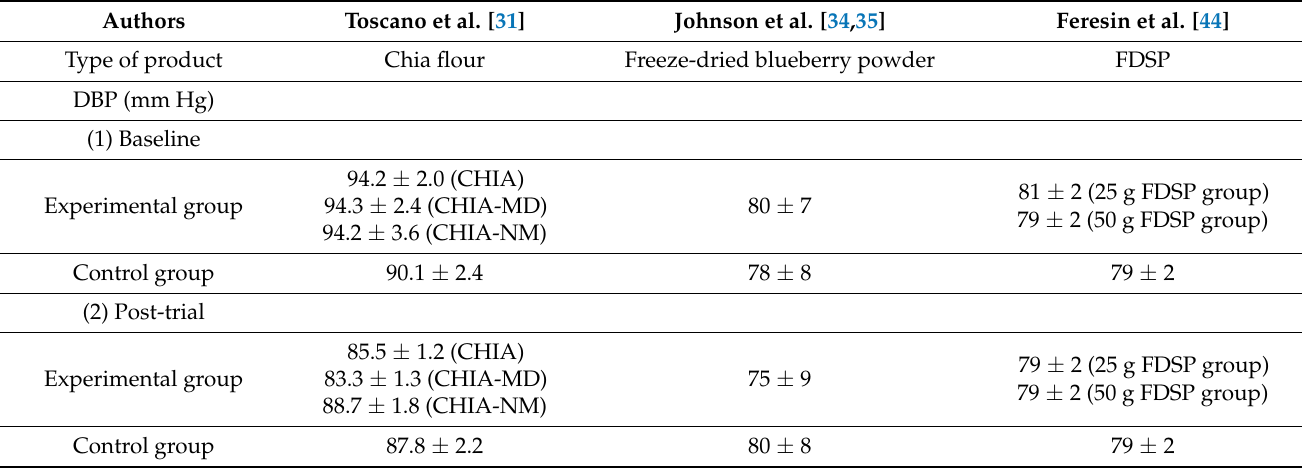
Table 6. Effects of specific nutrients on DBP